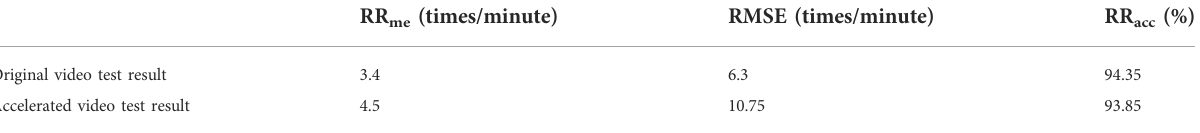
TABLE 7 The test result of the accelerated and original